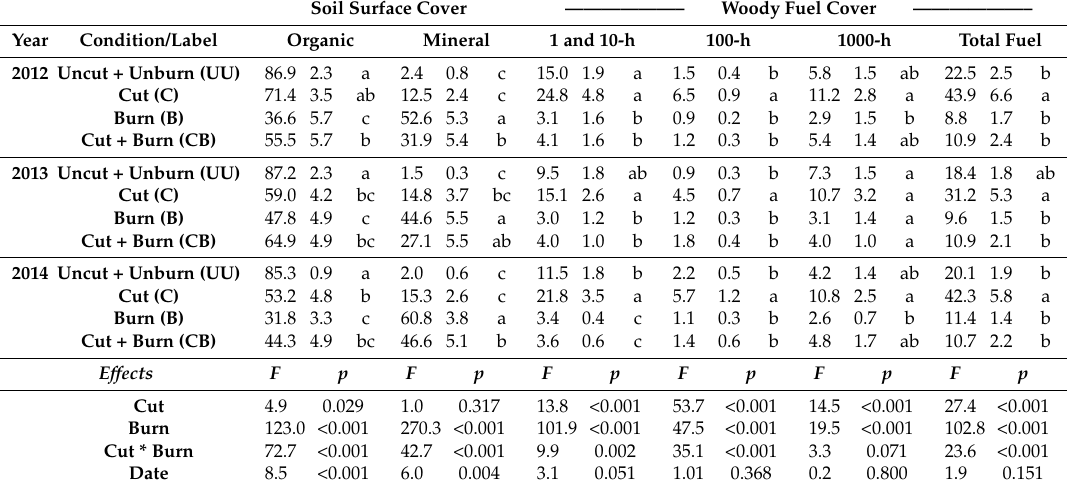
Table 1. Surface cover (%) after salvage logging and wildfire in bark beetle-infested lodgepole pine forests. Data are means with standard error for twelve stand-scale sampling areas per ecosystem condition per date. Different letters within columns denote differences within years based on Tukey’s pairwise adjusted comparisons.